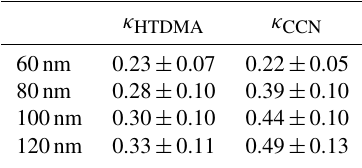
Table 2. Average CFSTGC-derived κ CCN values and HTDMA- derived κ HTDMA values for the selected particles sizes.